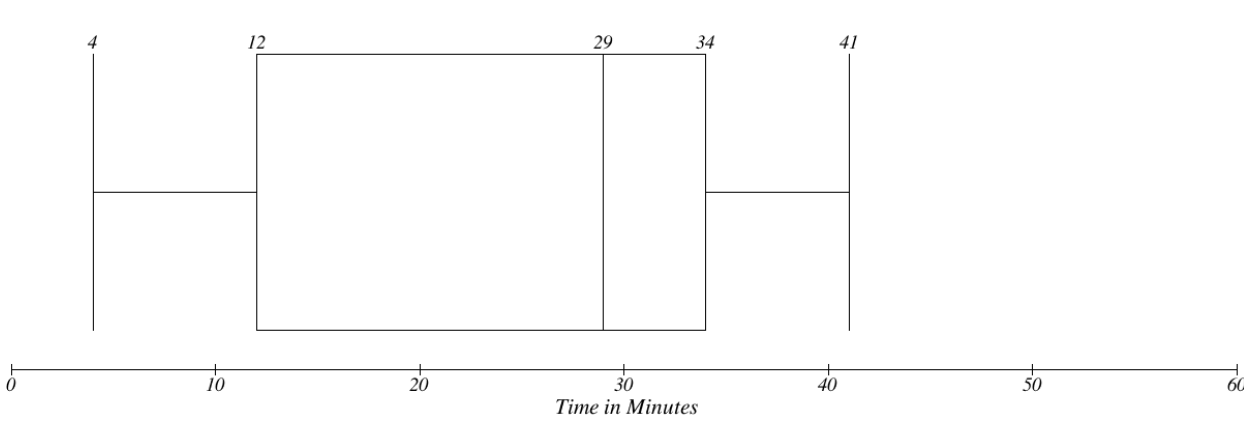
Figure 12. Overall time need in